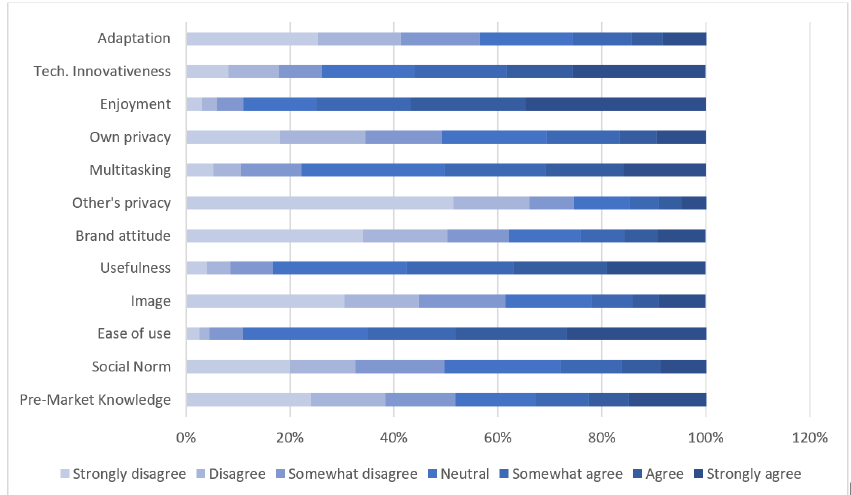
Fig. 8. User's perspective on the major factors data